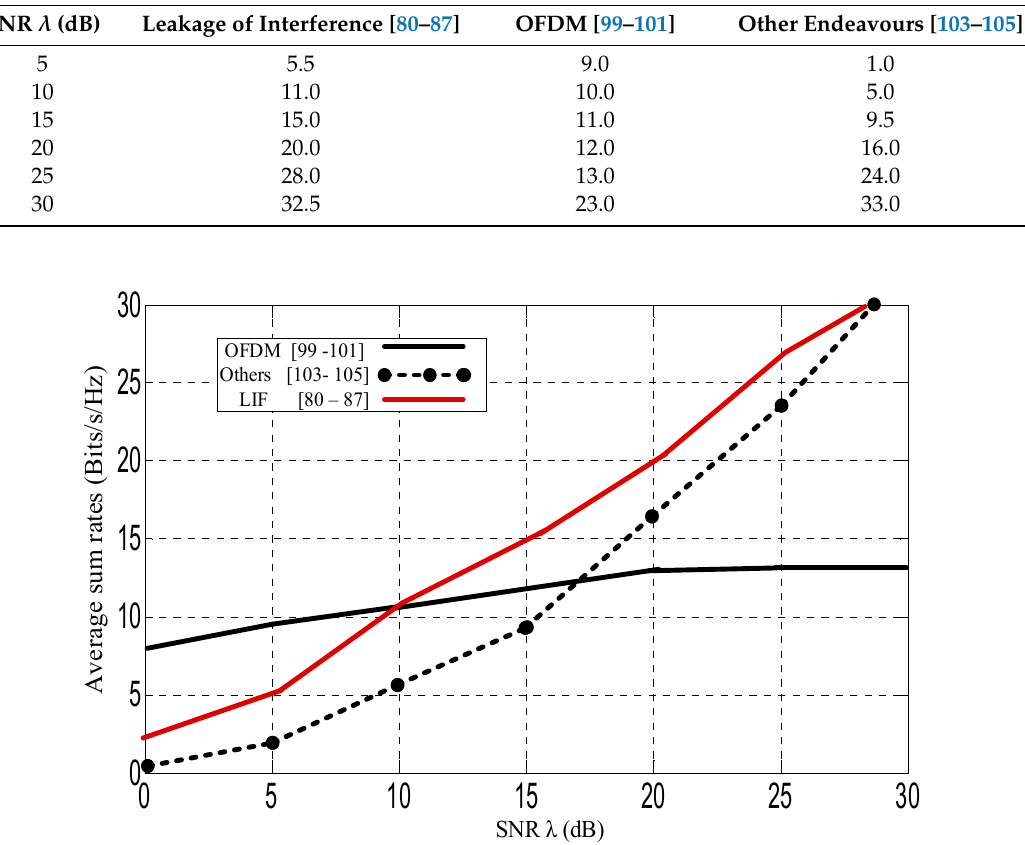
Table 4. Average sum rates against typical signal-to-noise ratio (SNR) values for the first paradigm